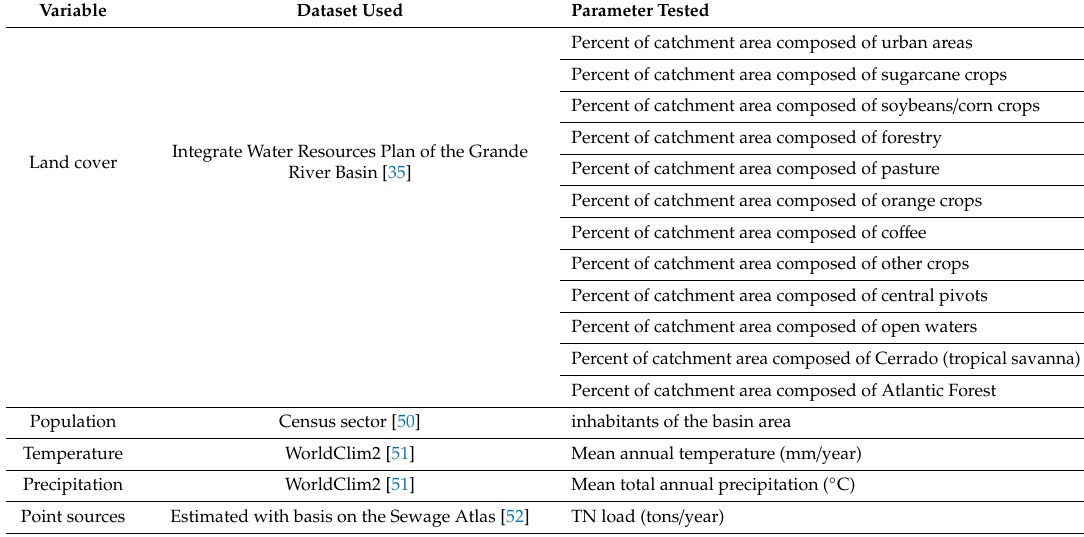
Table 1. Total nitrogen (TN) sources and landscape transport characteristics tested for potential inclusion in the SPAtially Referenced Regression On Watershed attributes (SPARROW)